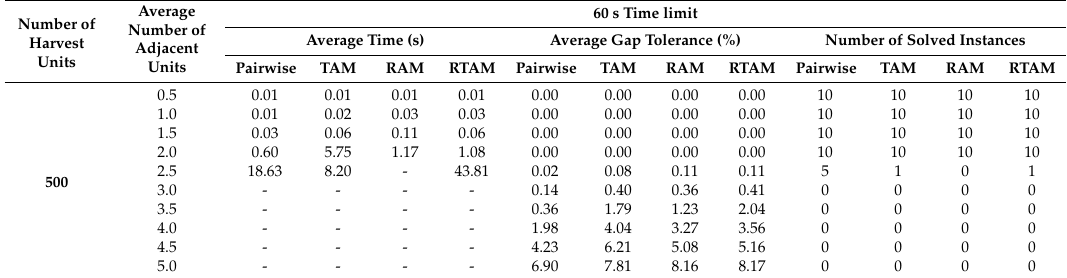
Table 5. Solving time, gap tolerance and number of solved instances for 60 s time limit and 500 harvest units.